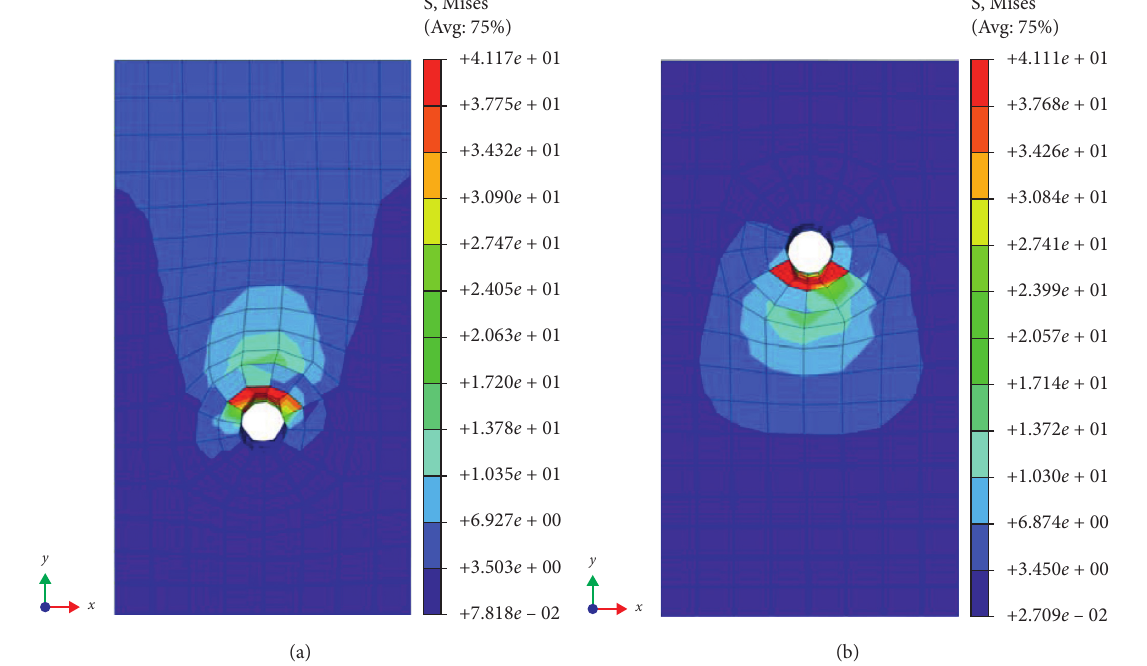
Figure 6: Stress contours for wood grooves in (a) centre member and (b) side member (combination